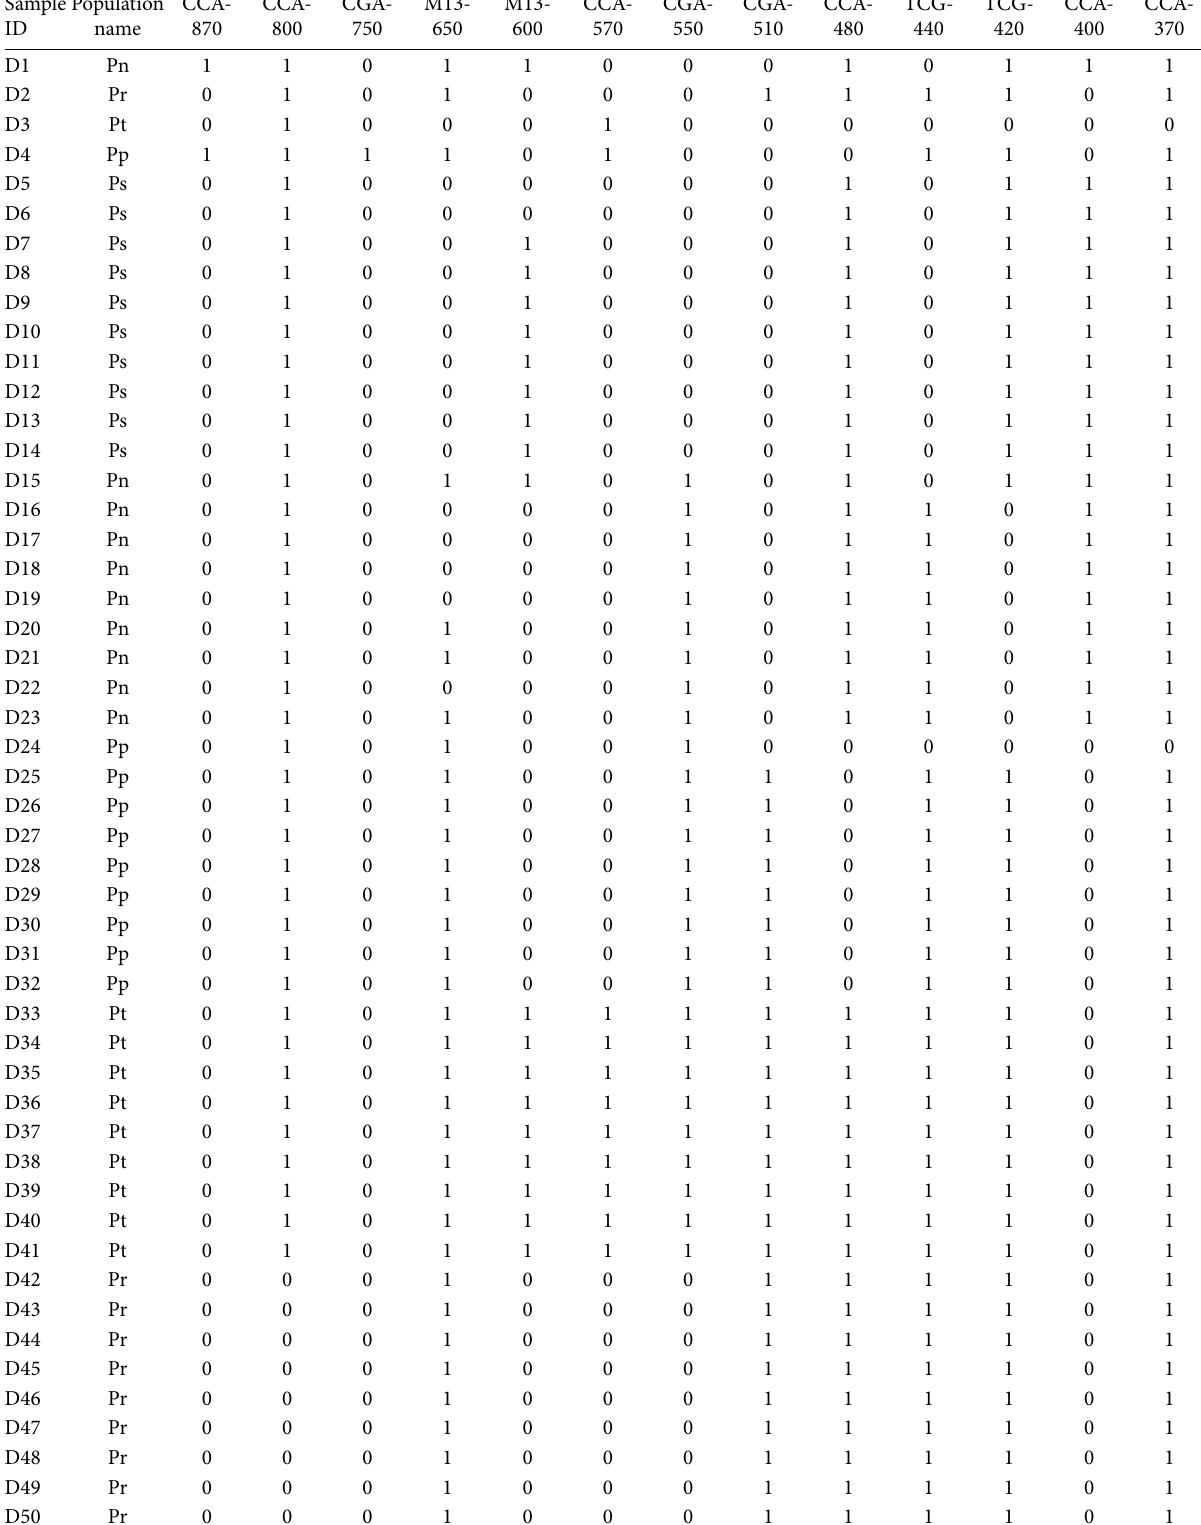
Table 5. Presence/absence (1⁄0) vector of Diplodia sapinea isolates tested with RAMS and M13 primers.